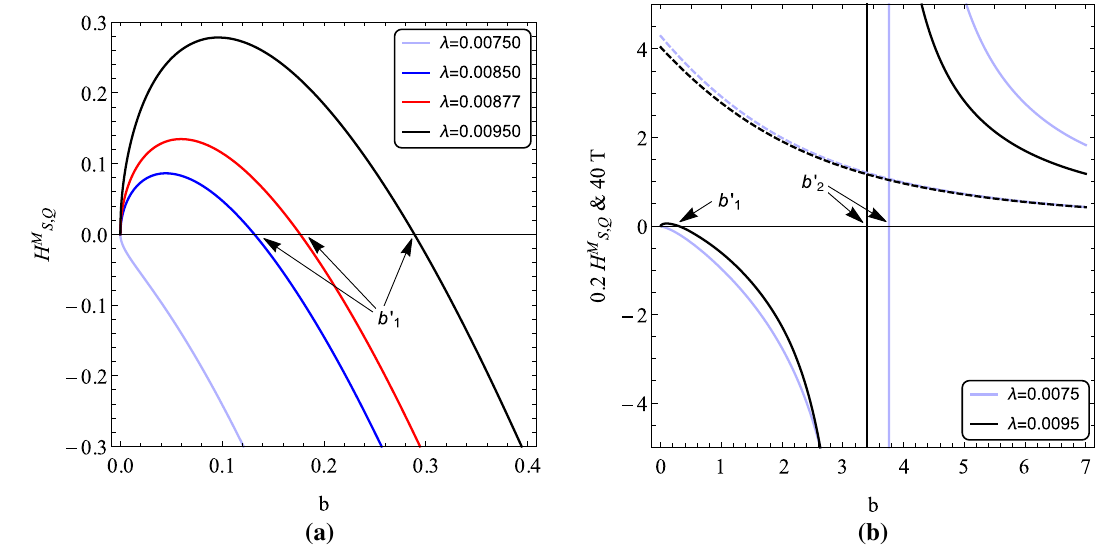
Fig. 3 The behavior of H M and T (dashed) versus b for different values of λ with q = 1 and r h = 0 . S , Q